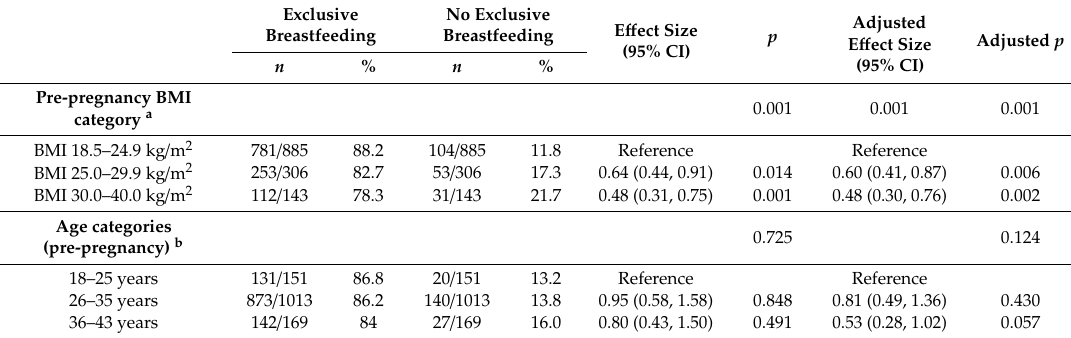
Table 5. Predictors of exclusive